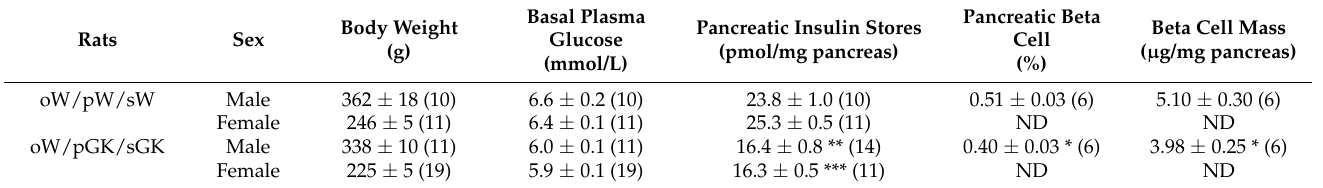
Table 1. Changes in body weight, basal plasma glucose level (post-absorptive state), pancreatic insulin stores and pancreatic beta cell mass in 10-wk-old oW/pW/sW rats obtained from W ovocyte transfer into W mothers and reared with W dams and in 10-wk-old oW/pGK/sGK rats obtained from W ovocyte transfer into GK mothers and reared with GK dam. oW: Wistar ovocyte; pGK: pregnant GK mother; pW: pregnant W mother; sGK: suckling GK mother; sW: suckling W